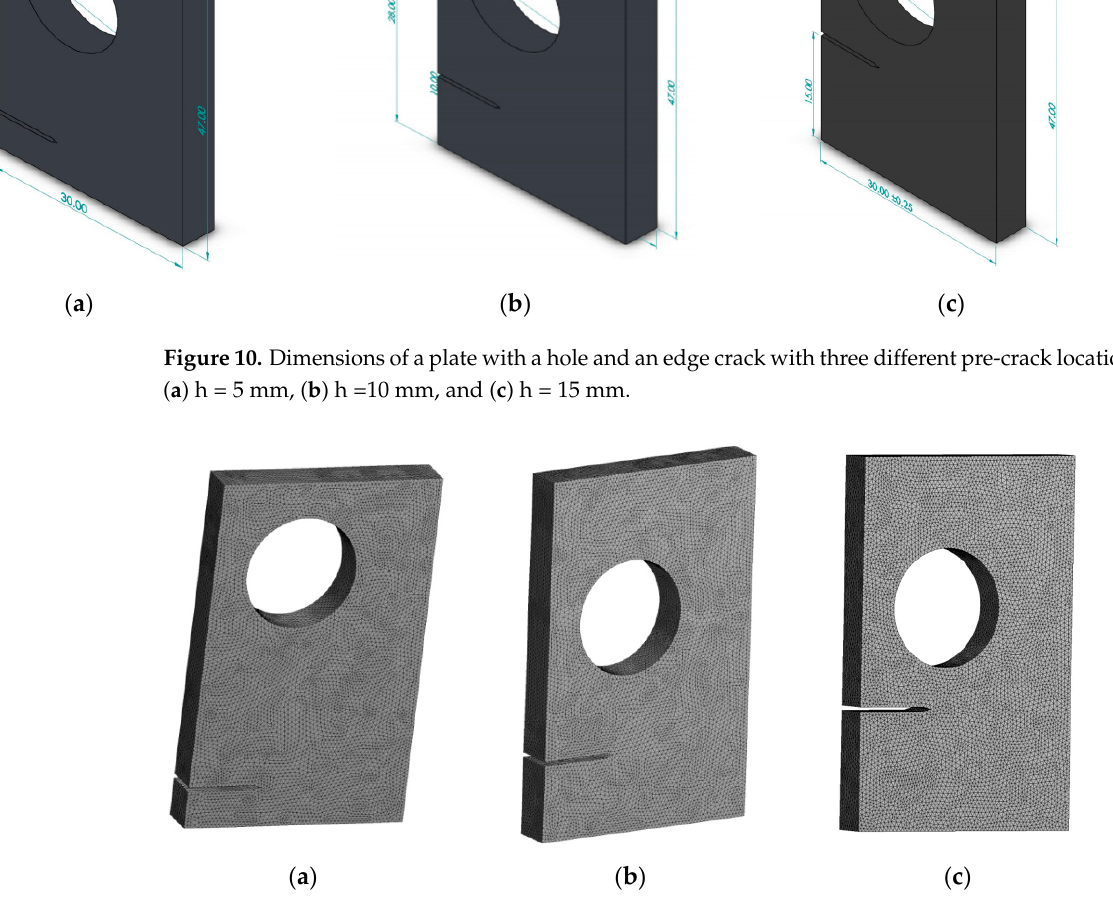
Figure 11. Initial mesh for the three configurations, ( a ) h = 5 mm, ( b ) h = 10 mm, and ( c ) h = 15 mm.